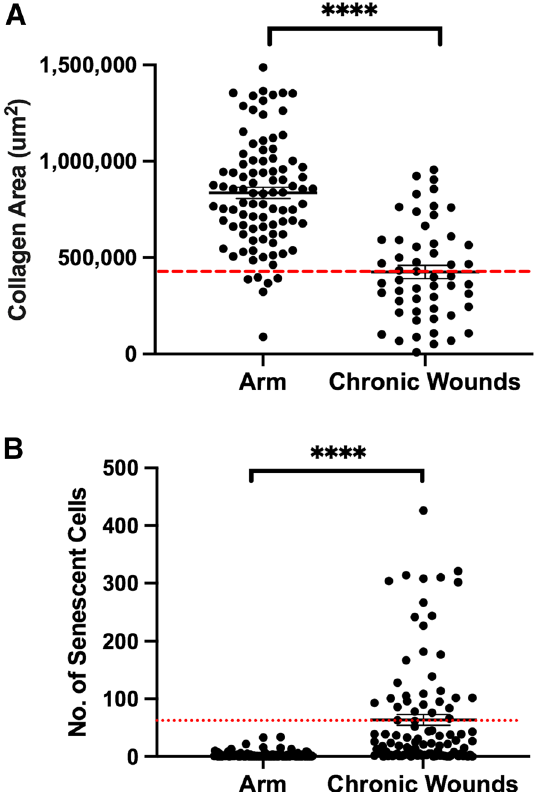
Figure 6. Collagen area and senescent cell numbers of all intact skins and chronic wounds in this study. Graphs showing ( a ) collagen area of arm and chronic wound tissues ( b ) senescent cell numbers of arm and chronic wounds respectively ( n = 26). Threshold of collagen and senescent cells denoted by red dashed lines across the graphs. Data shown as mean ± SEM. ****p <